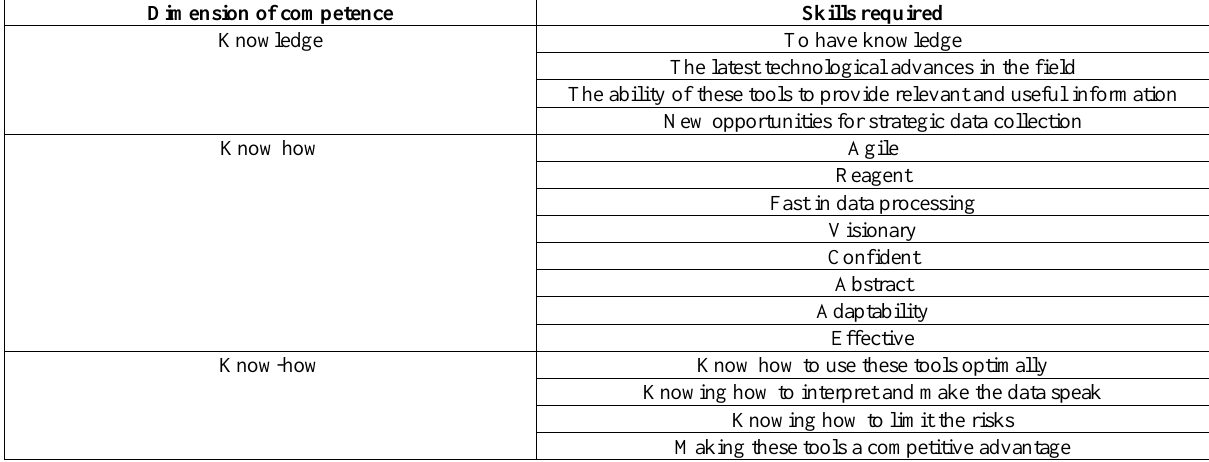
Table 3. Dimensions and New Skills Acquired by